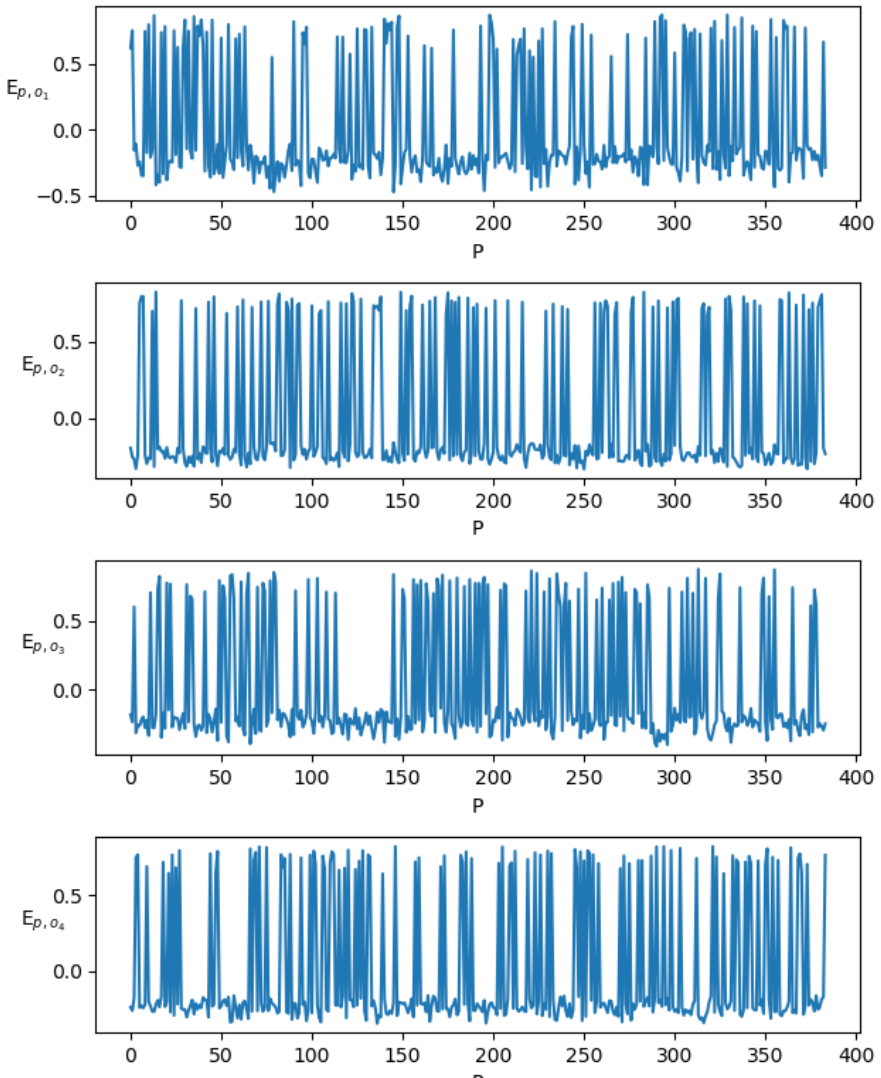
Figure 9. The error fluctuations of output units during training. When the jDE-B algorithm is adopted as the single-objective optimization method to fit the error fluctuations required for the above output units, the results are shown in Figure 10. P is the p-th sample, and S is the output value of the p-th sample in the hidden unit. The sum of the absolute values of the correlation between the output of the hidden unit and the residual signals of all the output units is S ≈ 65.72, and others S o ≈ 10.03, S ≈ 22.83, S ≈ S o . o 3 o 4 2